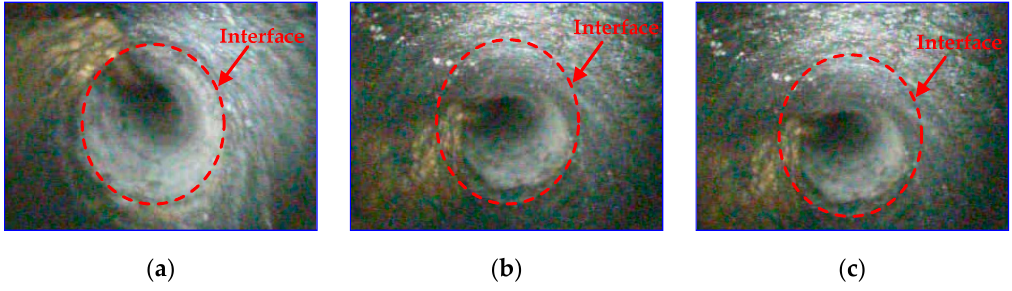
Figure 12. Images of the overburden around #1 characteristic point: ( a ) 100 m from the coalface; ( b ) 30 m from the coalface; ( c ) 20 m from the coalface.